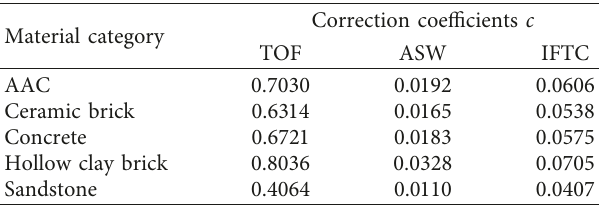
Figure 3. The correction coefficients for all group categories